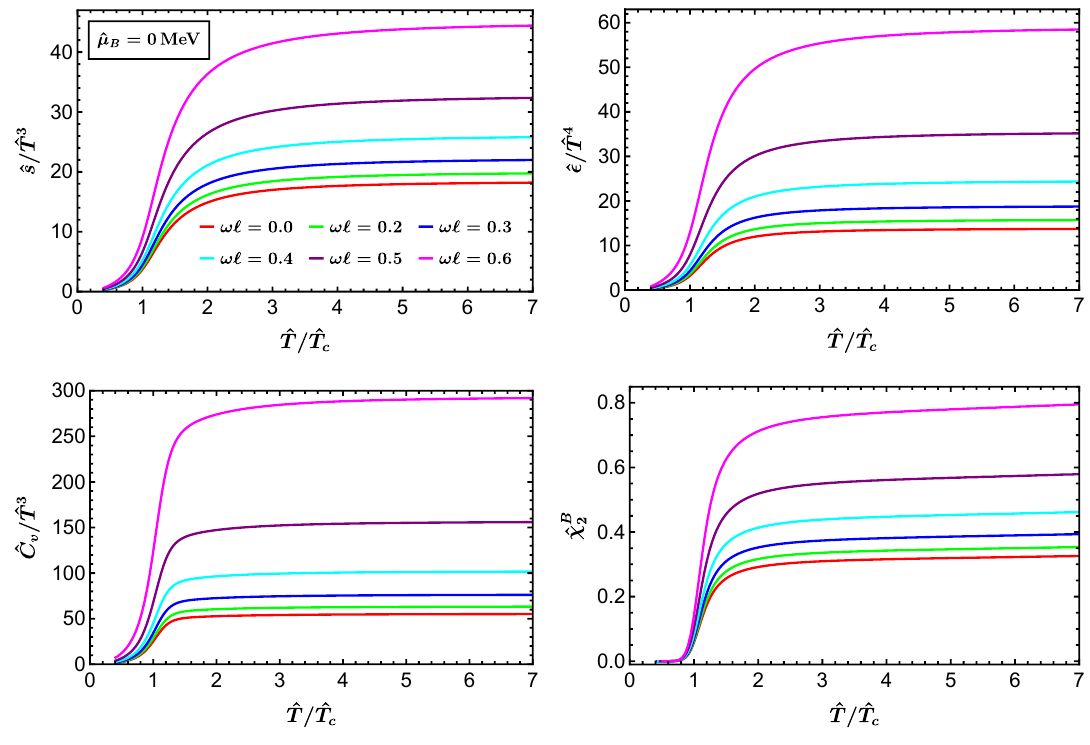
Figure 2 . Entropy density ˆ s , energy density ˆ (cid:15) , specific heat ˆ C v and baryon susceptibility ˆ χ B function of normalized temperature ˆ T/ ˆ T c at ˆ µ B = 0 for 2+1 flavor model. These quantities are all enhanced by increasing the angular